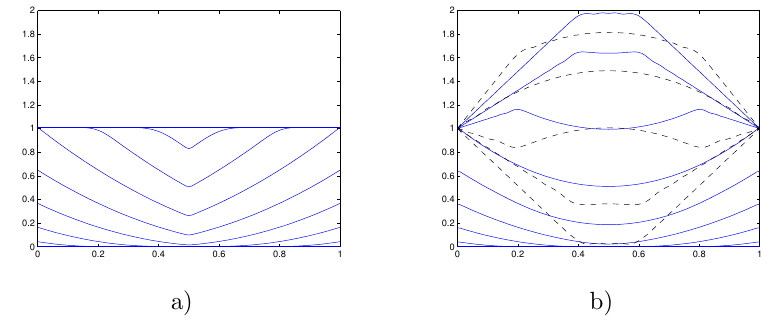
Figure 1. Behavior with respect to time (left) of the function E = E z in (3.1) with V obtained from (3.5). This is compared (right) with the solution of the wave equation (1.5) corresponding to the same boundary data. Inconsistent oscillations are produced in the second case, where the initial transient (solid lines) is followed by a periodic regime (dashed lines). The principal modes (sin πz and sin3 πz ) are clearly visible.